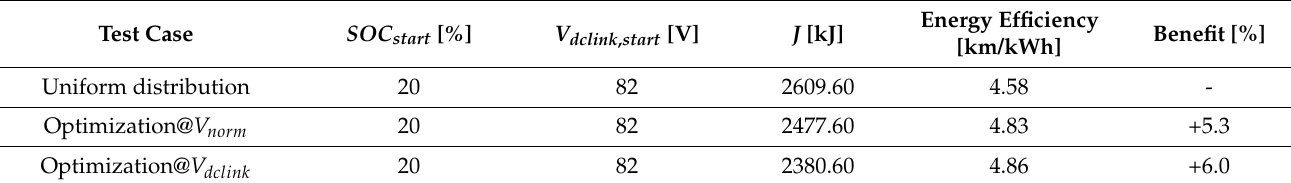
Table 6. Simulation